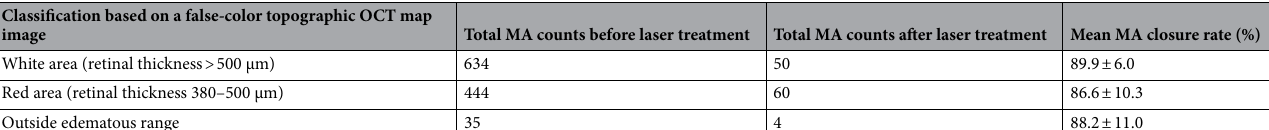
Classification based on a false-color topographic OCT map image Total MA counts before laser treatment Total MA counts after laser treatment Mean MA closure rate